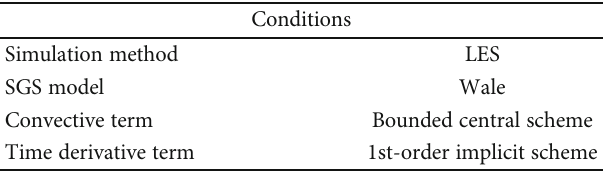
Table 1: The conditions of the numerical simulation.